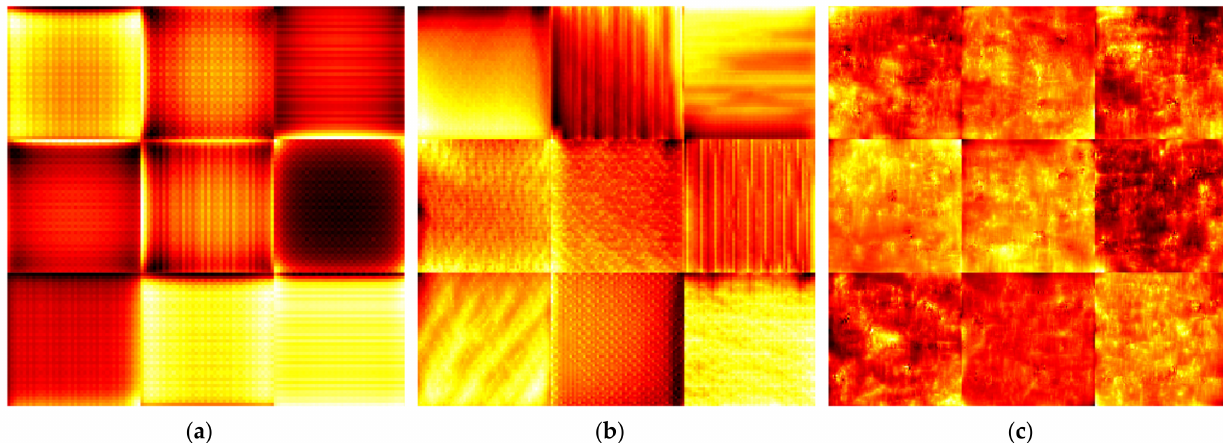
Figure 5. Examples of features extracted from YAMNet trained with AudioSet data: ( a ) low-level features; ( b ) medium-level features; ( c ) high-level